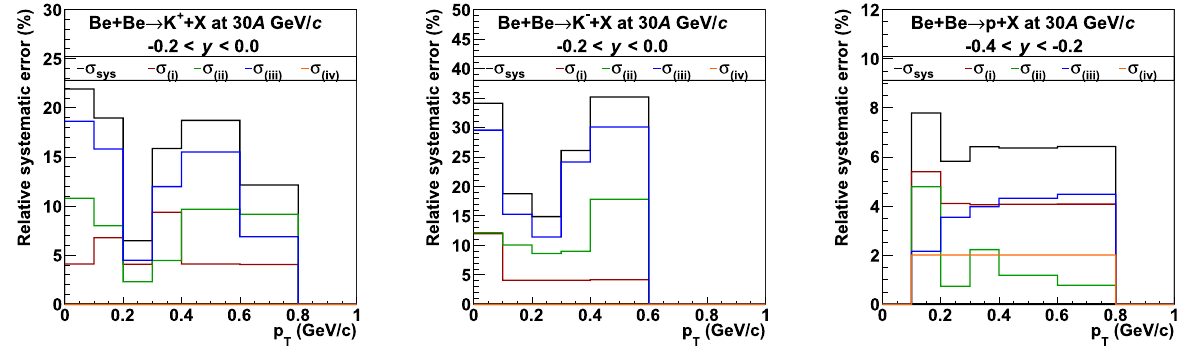
Fig. 18 Contributions to the systematic uncertainty of particle spectra obtained from the tof -d E / d x method at 30 A GeV / c as a function of p T for the rapidity interval − 0.2 to 0.0 GeV / c ( K + and K − ) and − 0.4 to − 0.2 GeV / c (protons). σ (i) (red lines) refers to event selection σ (ii) (green lines) to the track selection procedure, σ (iii) (blue lines) to the